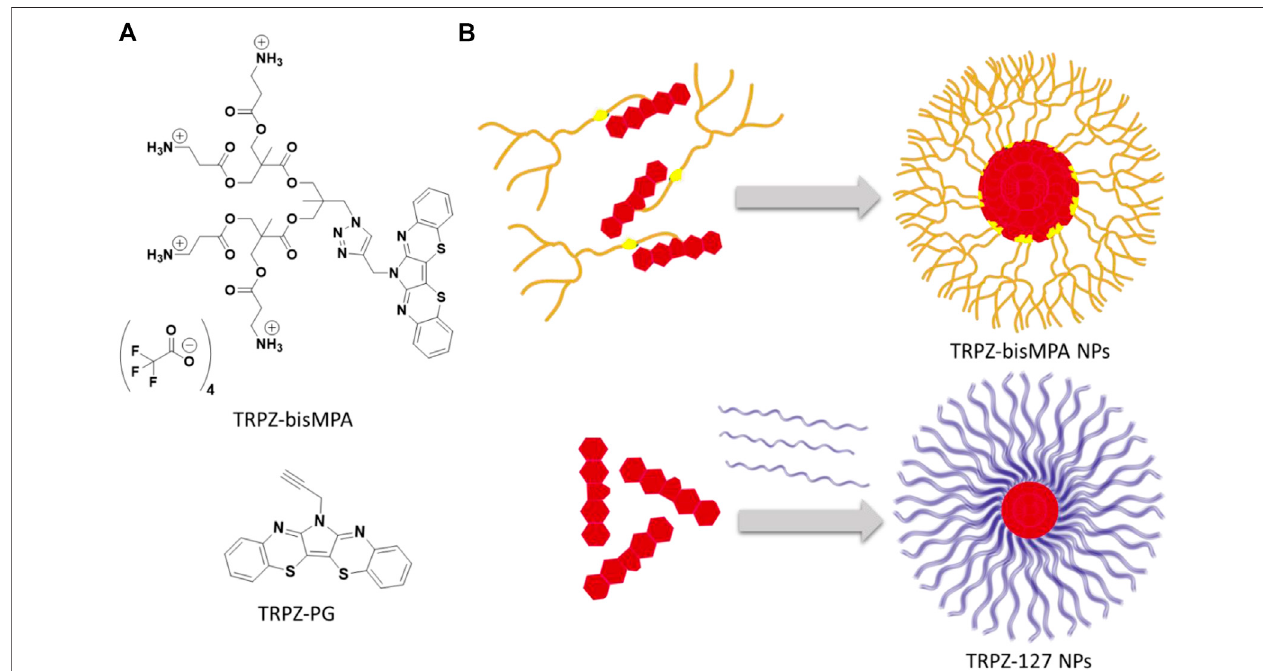
FIGURE 1 | Structure of TRPZ-bisMPA (top) and TRPZ-PG (bottom) (A) ; depiction of TRPZ-bisMPA dye-polymer amphiphile self-assembly and TRPZ-PG- Pluronic F-127 (TRPZ-127) (B) .